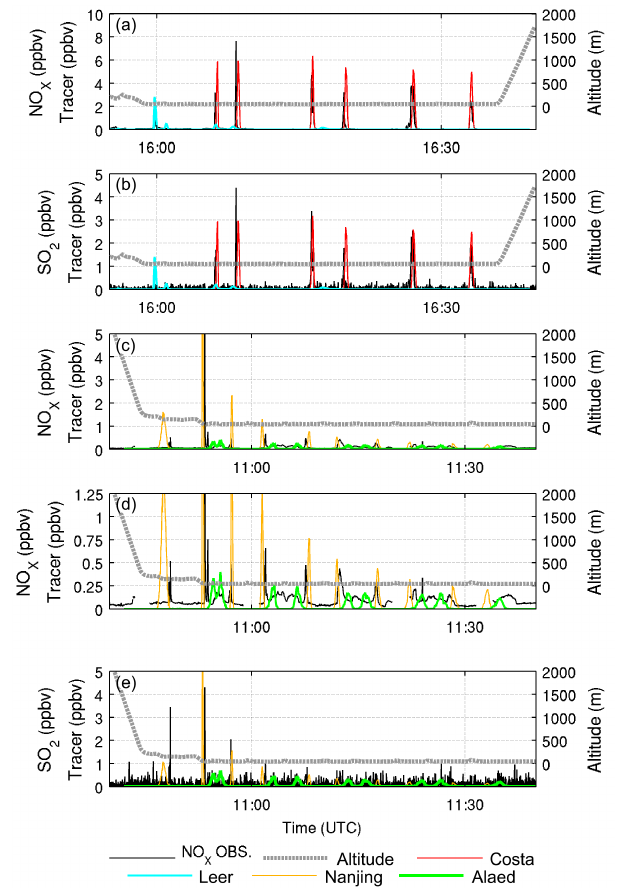
Figure 4. (a, c, d) NO x and (b, e) SO 2 aircraft measurements (black) compared to FLEXPART-WRF air tracer mixing ratios in- terpolated along flight tracks, for the plumes of the (a, b) Costa Deliziosa and Wilson Leer on 11 July 2012 (first constant altitude level ( Z ∼ 49m), also shown in Fig. 3a) and (c, d, e) Wilson Nan- jing and Alaed on 12 July 2012. Panel (d) shows the same results as panel (c) in detail. Since model results depend linearly on the emission flux chosen a priori for each ship, model results have been scaled so that peak heights are comparable to the